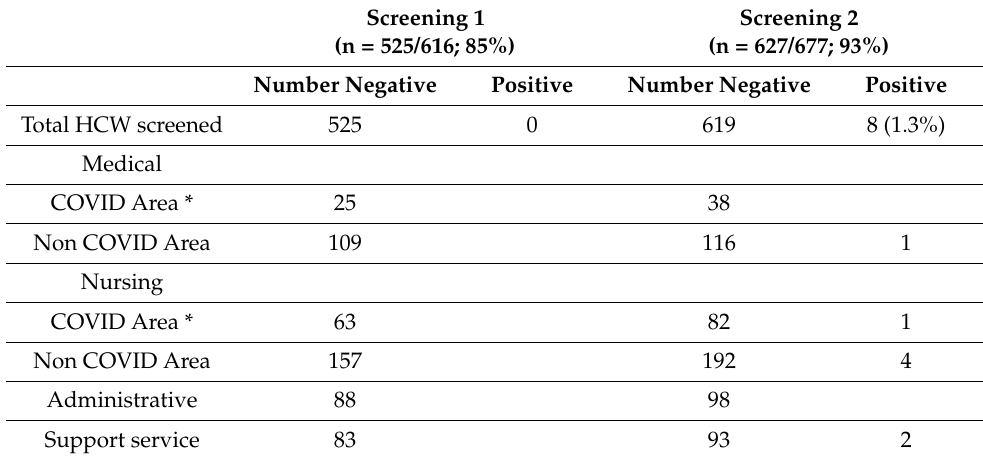
Table 1. Number and distribution of health care workers (HCW)